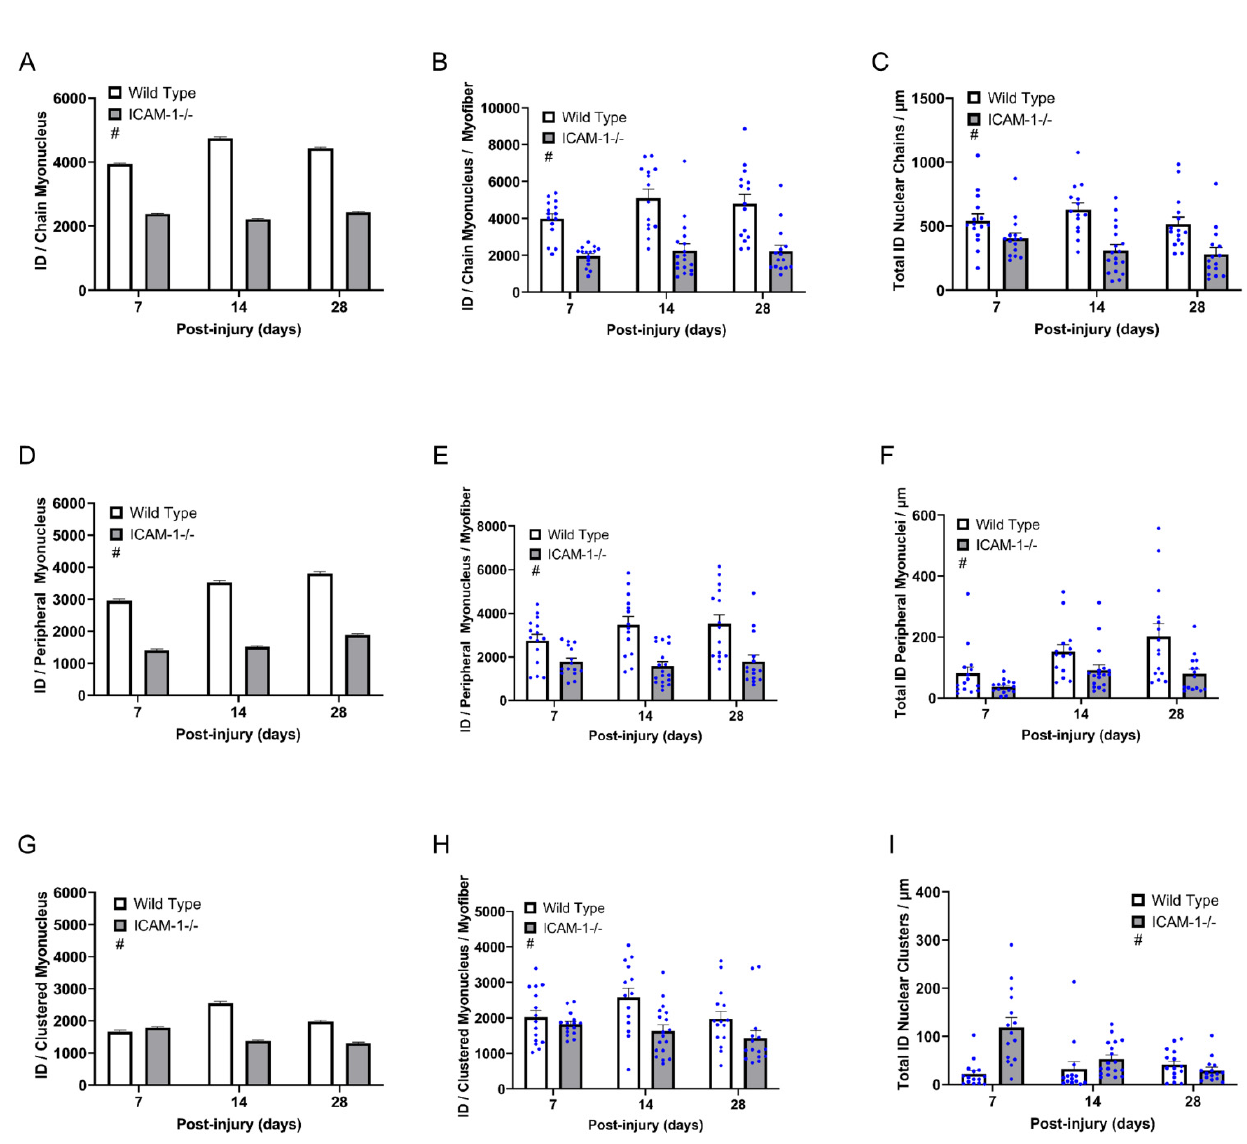
Figure 6. Positional context of transcriptional activity of individual myonuclei before and during injury-induced muscle regeneration. An integrated density (ID) of EU was calculated for each myonucleus to represent its transcriptional activity, as described in the Methods. ( A ) Integrated density per chain myonucleus ( n = 5529–7850). ( B ) Integrated density per chain myonucleus when averaged on a per myofiber basis ( n = 14–18 myofibers per time point/genotype. ( C ) Total integrated density of chain myonuclei per myofiber length ( µ m) ( n = 14–18 myofibers per time point/genotype). ( D ) Integrated density per peripheral myonucleus ( n = 891–3230). ( E ) Integrated density per peripheral myonucleus when averaged on a per myofiber basis ( n = 14–18 myofibers per time point/genotype. ( F ) Total integrated density of peripheral myonuclei per myofiber length ( µ m) ( n = 14–18 myofibers per time point/genotype). ( G ) Integrated density per clustered myonucleus ( n = 594–2386). ( H ) Integrated density per clustered myonucleus when averaged on a per myofiber basis ( n = 14–18 myofibers per time point/genotype ( I ) Total integrated density of clustered my- onuclei per myofiber length ( µ m) ( n = 14–18 myofibers per time point/genotype). # = higher for Wild Type compared to ICAM-1-/- mice (main effect; p ≤ 0.001) for ( A – G ). # = higher for ICAM-1-/- compared to Wild Type (main effect; p ≤ 0.001) for ( I